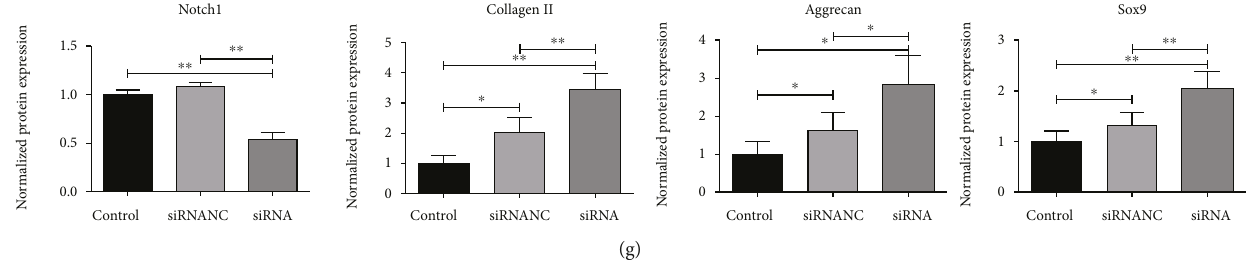
Figure 4: Notch1 pathway was negatively associated with exosome-induced MSC di ff erentiation. (a) Gene expression of Notch1, Hes1, and Hey1 was signi fi cantly downregulated in DAPT-treated MSCs. Vehicle: DMSO. (b) DAPT enhanced the expression of collagen II, aggrecan, and Sox9 in exosome-treated MSCs. Vehicle: DMSO. (c) Gene expression of Notch1, Hes1, and Hey1 was signi fi cantly upregulated in SJAG- treated MSCs. Vehicle: PBS. (d) SJAG enhanced the expression of collagen II, aggrecan, and Sox9 in exosome-treated MSCs. Vehicle: PBS. (e) Western blot analysis of Notch1, Hes1, Hey1, collagen II, aggrecan, and Sox9 in MSCs treated under the same condition as (b) and (d). (f, g) Inhibition of Notch1 protein promoted the protein expression of collagen II, aggrecan, and Sox9 in exosome-treated MSCs. Control: MSCs treated with NPC exosomes (50 μ g/ml); siRNA NC: MSCs treated with NPC exosomes (50 μ g/ml) and Notch1 siRNA- negative control; siRNA: MSCs treated with NPC exosomes (50 μ g/ml) and Notch1 siRNA. All data were showed as mean ± SD . N = 3 . ∗ P < 0 05 , ∗∗ P < 0 01 , and ∗∗∗ P < 0 001